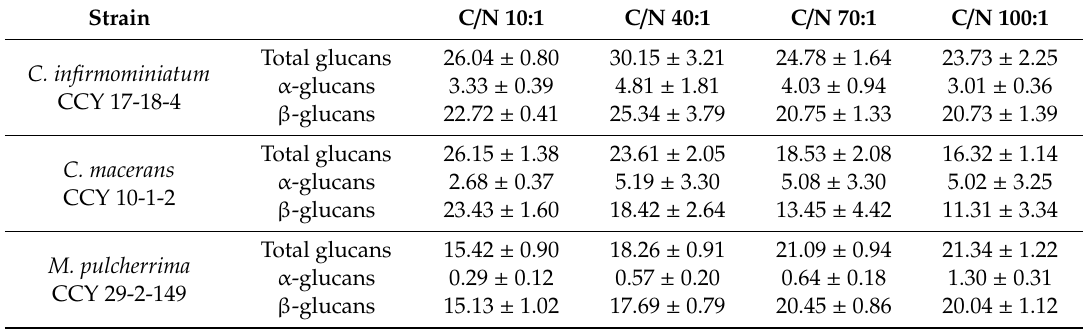
Table 3. Total glucans, α - and β -glucan content (% of cell dry weight (CDW) in yeast grown in the media with low and high C / N